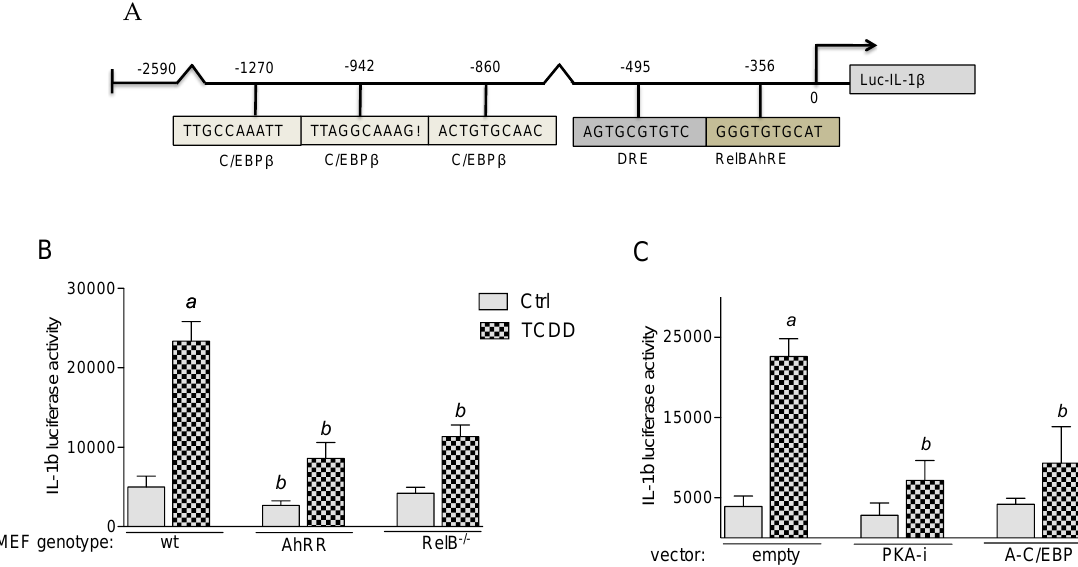
Figure 5. TCDD-induced IL-1β promoter activity is RelB and PKA-C/EBPβ-dependent. ( A ) Potential binding sites of the full-length promoter construct of the mouse IL- 1β gene containing 2590 bp upstream of the transcriptional start site (indicated by an arrow) cloned into a luciferase ( luc ) reporter vector. Positions of one putative DRE consensus, one non-consensus DRE (RelBAhRE) and three recognition sites for C/EBP β are presented. ( B ) MEF from wt, AhRR Tg, and RelB −/− mice were transfected with a luciferase reporter construct containing 2590 bp (IL-1β) of the mouse gene promoter region. ( C ) MEF wt were cotransfected with an empty, PKA inhibitor (PKA-i) and C/EBP dominant negative expression plasmid. 24 h after transfection, MEF were treated with 1 nM TCDD for 6 h. Relative luciferase activity units are given as mean values of triplicates as a result of three independent experiments. a significantly different from control cells ( p < 0.05); b significantly lower than MEF wt or cells co-transfected with empty vector ( p < 0.05).